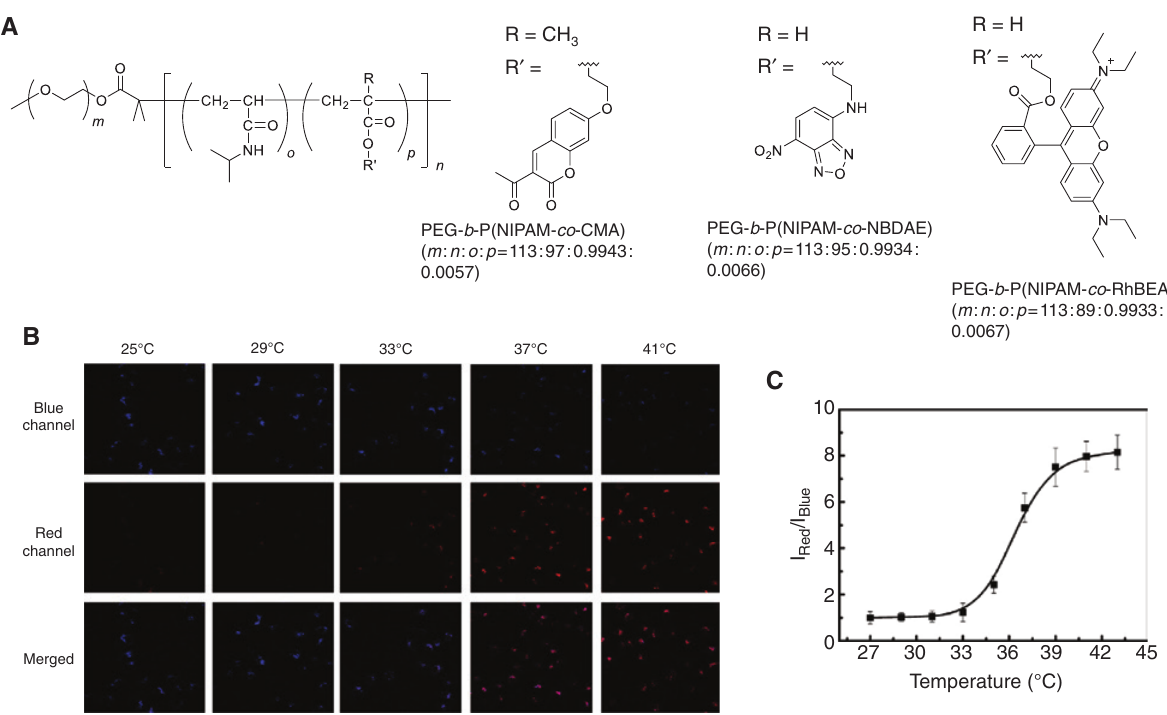
Figure 10: FRET-based ratiometric fluorescent thermometers for intracellular thermometry. (A) Chemical structures of PEG- b -P(NIPAM- co -CMA) ( M = 14.9 kDa). (B) Confocal fluorescence images of HepG2 cells incorporating the three polymeric thermometers (blue channel: RhBEA) ( M n 410–450 nm, red channel: 565–605 nm) and their merged images at different temperatures ( λ fluorescence intensity ratio of the two channels (I 2015 American Chemical